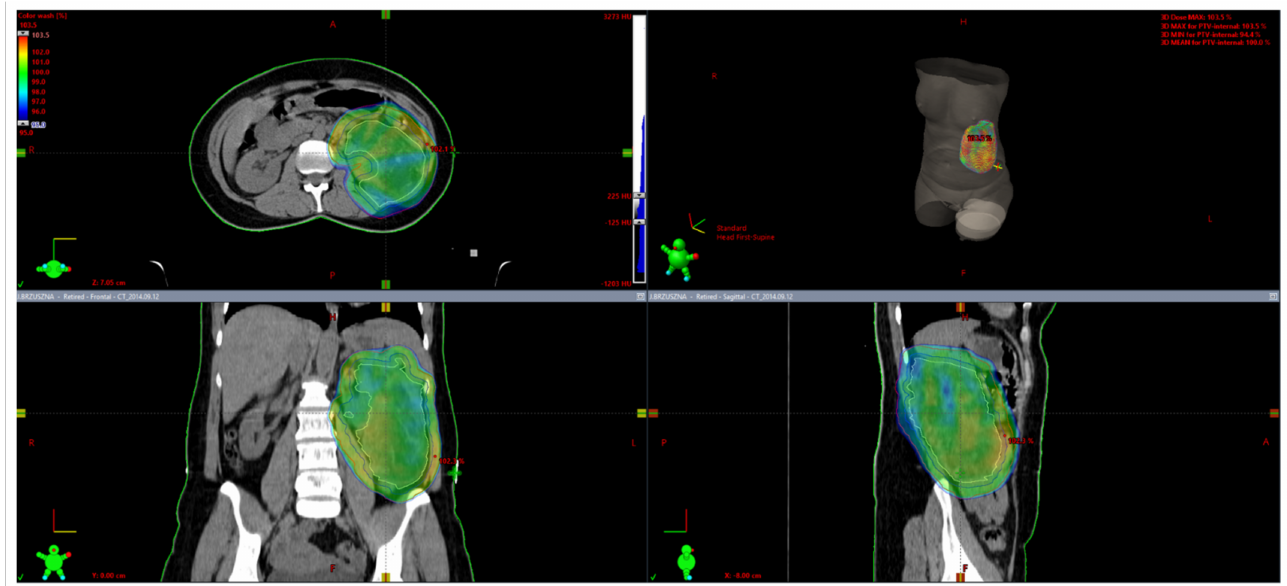
Figure 4. Radiotherapy treatment plan with dose distribution (50.4 Gy of preoperative radiotherapy in 28 fractions) for a patient with locally advanced retroperitoneal PEComa. Figure by Mateusz J. Spałek (Varian Aria